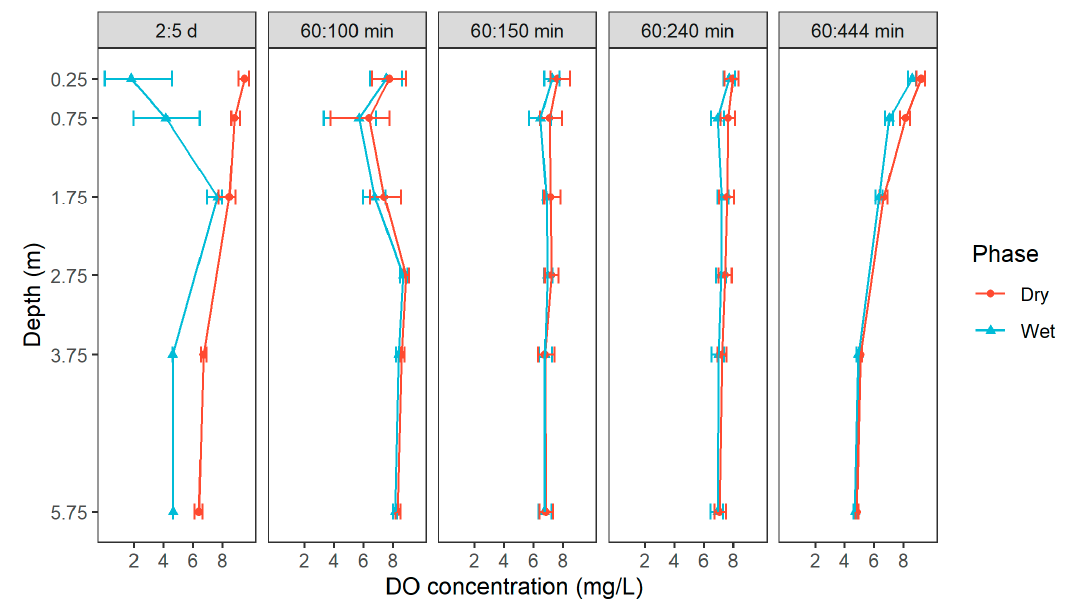
Figure 2. Depth profiles of DO (mg/L) along the 6 m soil column for different scenarios separated into wet phase (infiltration) and dry phase (no infiltration). Values are maximum DO during the dry phase and minimum DO during the wet phase averaged over ten infiltration cycles. Range of values is indicated by error bars. Additional scenarios are depicted in Supplementary Figure S1.